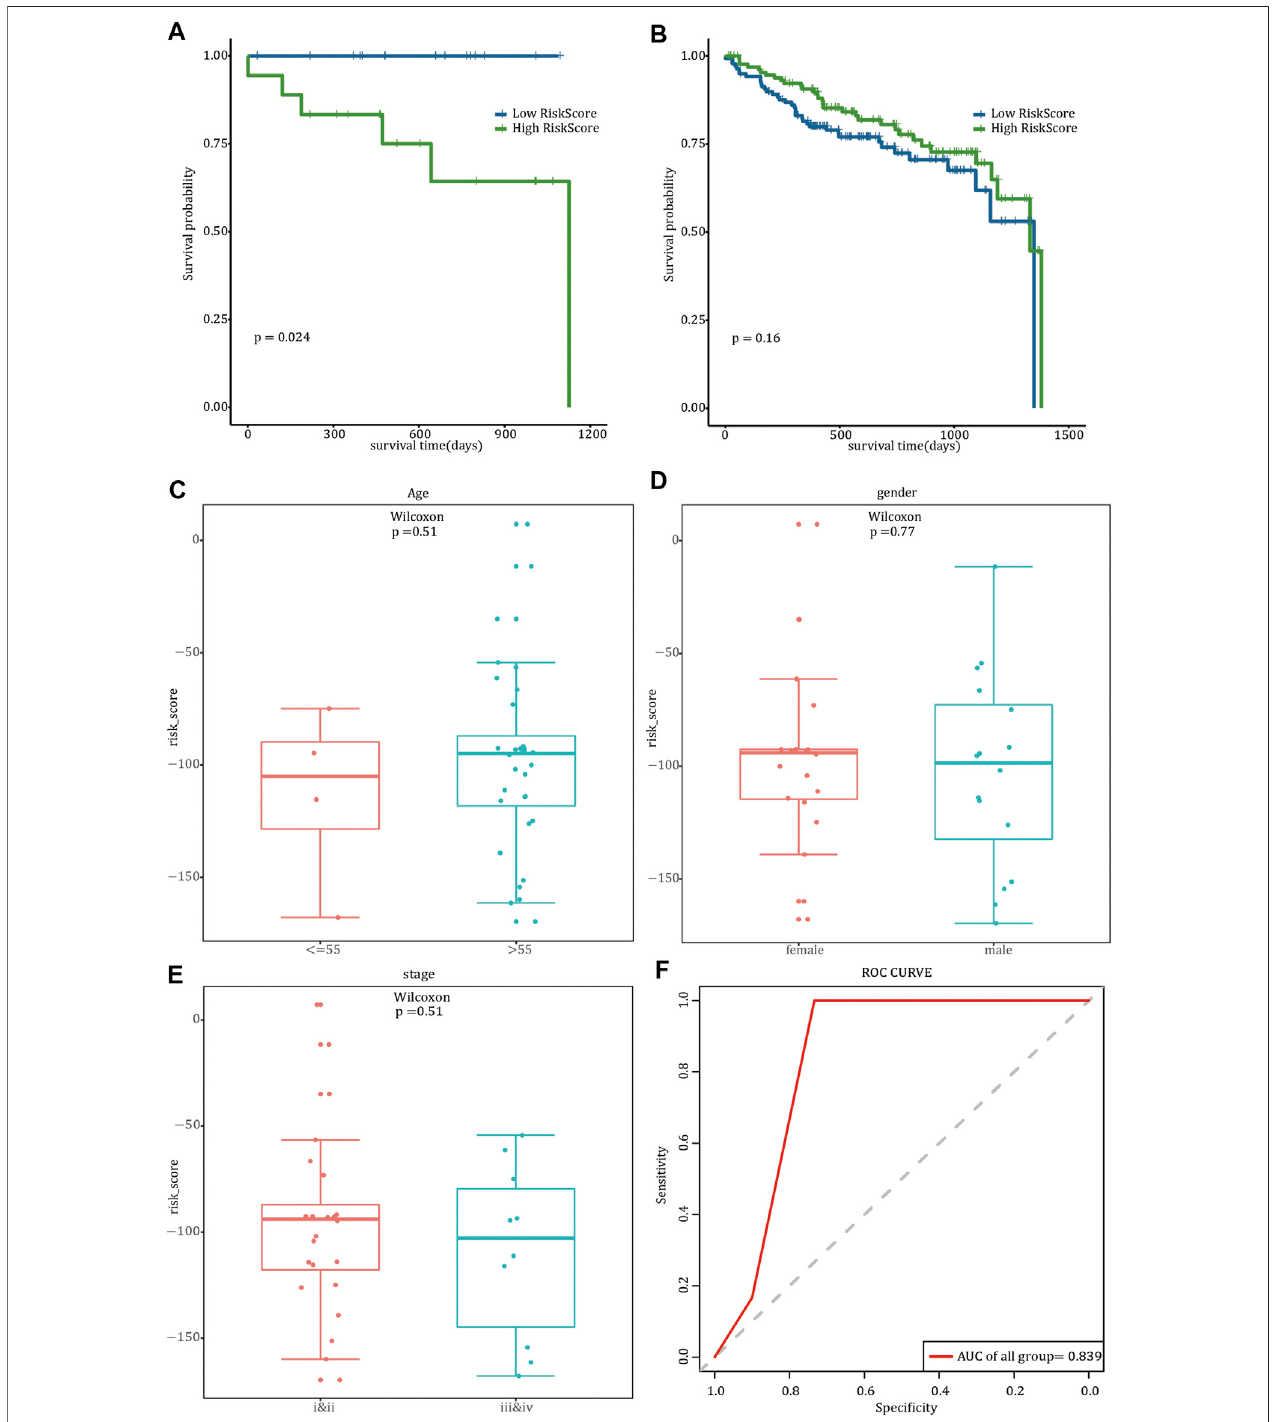
FIGURE 4 | Prognostic model analysis and clinical model construction. The effect of risk score on overall survival of FREM2 -mutant type (A) and FREM2 -wild type (B) patients. Blue indicates low risk score, and green indicates high risk score. Correlation analysis of risk score with age (C) , gender (D) , and tumor stage (E) . (F) The receiver operating characteristic curve of the clinical prediction model in 36 FREM2 -mutant samples.